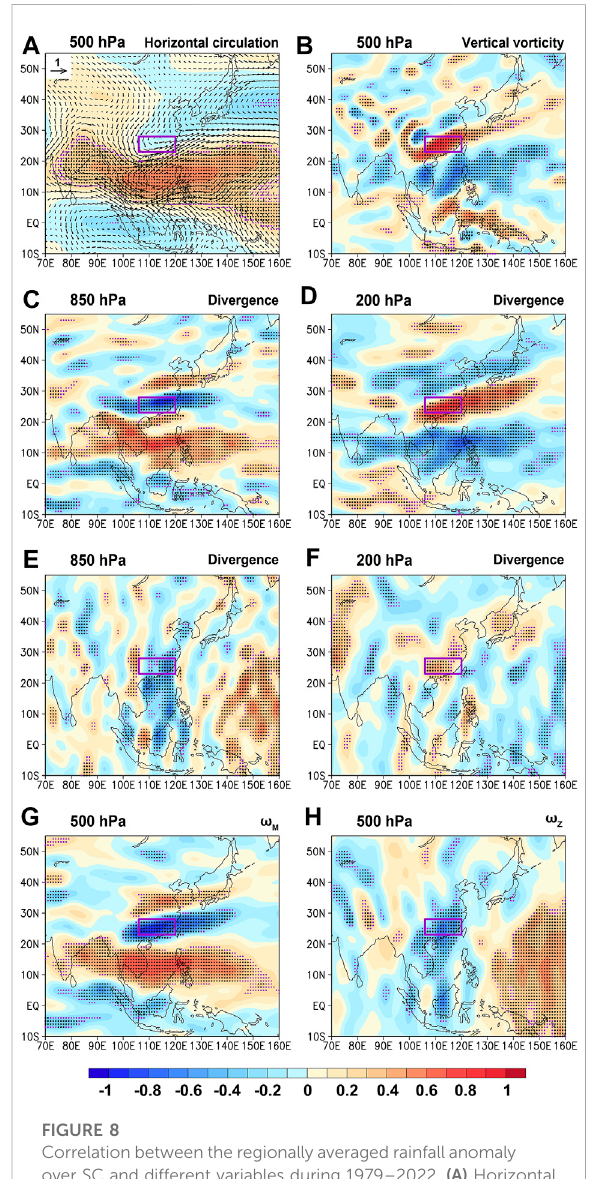
FIGURE 8 Correlation between the regionally averaged rainfall anomaly over SC and different variables during 1979 – 2022. (A) Horizontal circulation anomaly at 500 hPa. Shading and vector are for the stream function anomaly and wind anomaly of the horizontal circulation. (B) Vertical vorticity anomaly of horizontal circulation at 500 hPa. (C),(D) Divergence anomaly of meridional circulation at (C) 850 hPa and (D) 200 hPa. (E),(F) are the same as (C),(D) but for the zonal circulation. (G),(H) Vertical velocity anomaly of the (G) meridional and (H) zonalcirculationsat500 hPa.Black(purple) dots over the shading represent that those correlation coef fi cients are signi fi cant above the 95% (90%) con fi dence level based on Student ’ s t